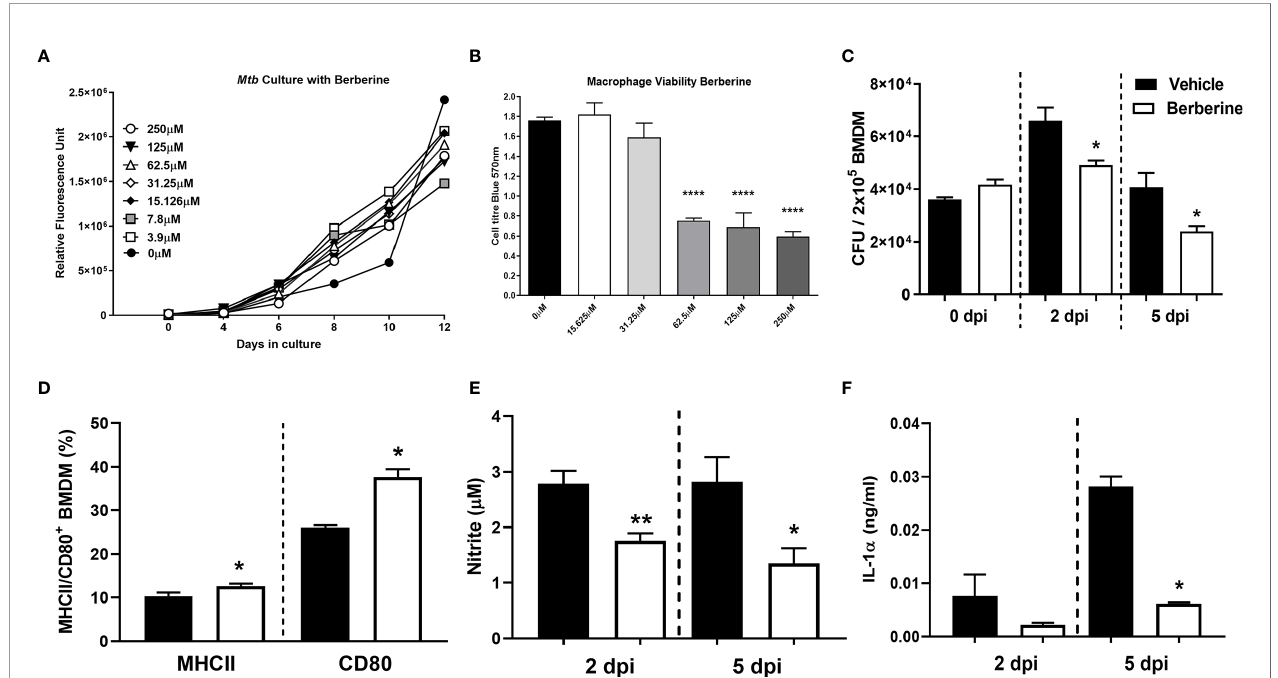
FIGURE 1 | Cytotoxic effect of berberine on Mycobacterium tuberculosis ( Mtb ) and macrophages. (A) Mtb was cultured in 7H9 culture broth at the indicated concentrations of berberine to determine the mycobactericidal activity. (B) C57BL/6 murine BMDMs were treated with indicated concentrations of berberine for 3 days to measure cellular viability using Cell Titer Blue assay. (C) Murine macrophages were pre-treated with berberine (30 µM) overnight. Cells were then infected with Mtb (MOI=1) to determine the growth in a time-dependent manner. (D) BMDM were infected with Mtb for two days and stained for MHCII and CD80 antibodies to measure macrophage activation in the presence of berberine. (E, F) Cell culture supernatants were analysed for nitrite by Griess Reagent Assay and IL-1 a by ELISA. Data represented as mean ± SEM of triplicates and representative of two experiments, analysed by one-way ANOVA with Tukey post-hoc test (A, B) or two- tailed unpaired Student ’ s t-test (C, D) or Mann-Whitney test (E, F) de fi ning differences in all groups as signi fi cant *P ≤ 0.05; **P ≤ 0.01; ****P ≤